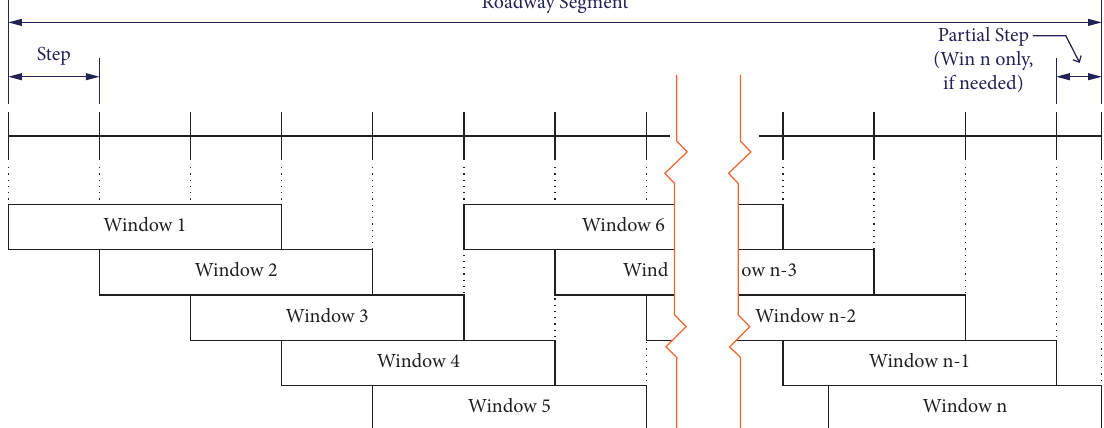
Figure 3: Sliding window searching method.